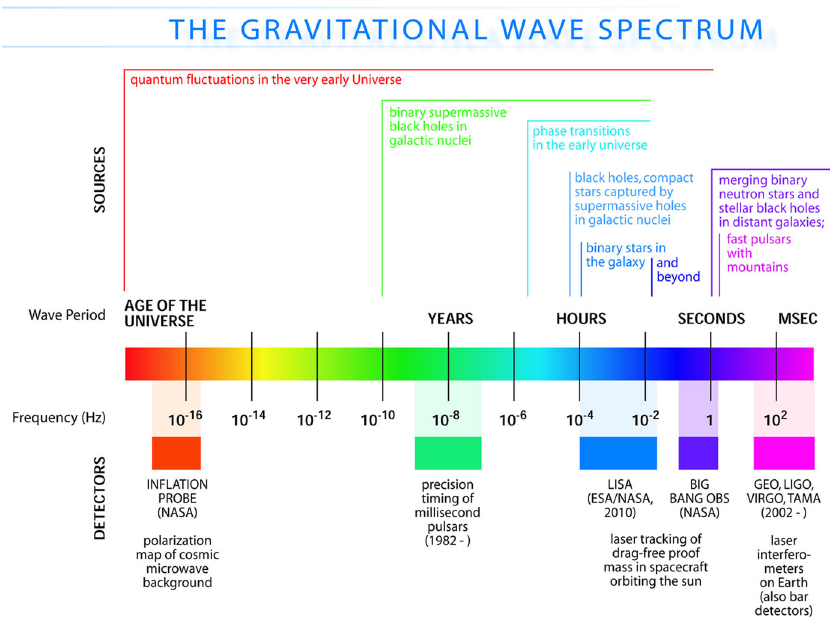
Fig. 1 Gravitational-wave spectrum, together with potential sources and relevant detectors. Image credit Institute of Gravitational Research/University of Glasgow limiting 2 noise sources below 10 Hz, and photon shot noise above a couple of